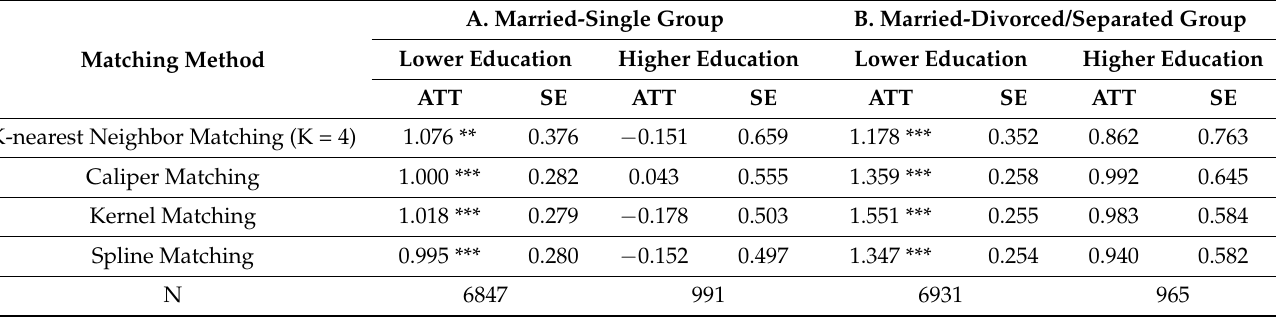
Table 5. Heterogeneous effects of parental